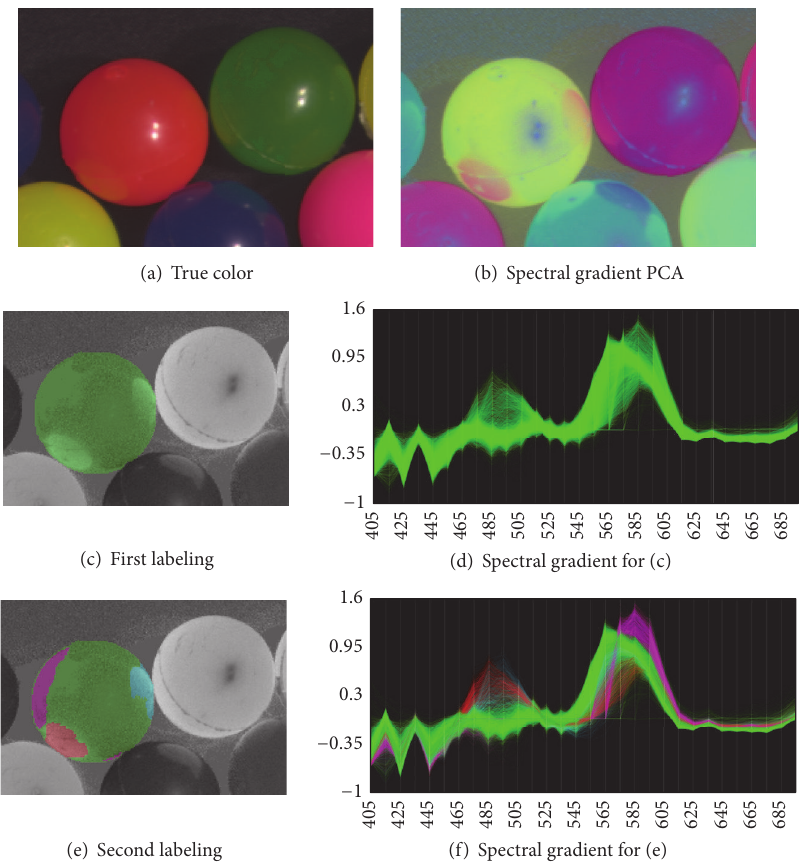
Figure 6: Inspection of cropped superballs image. Labelings are shown as overlay on the spectral gradient at 490–500 nm.